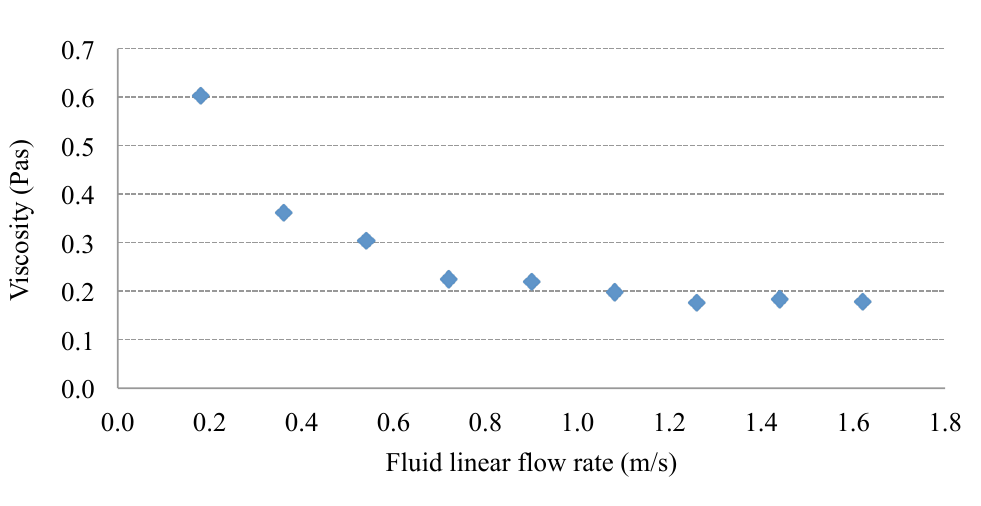
Figure 11. The dynamic viscosity of the ERF at 18.5 ◦ C is